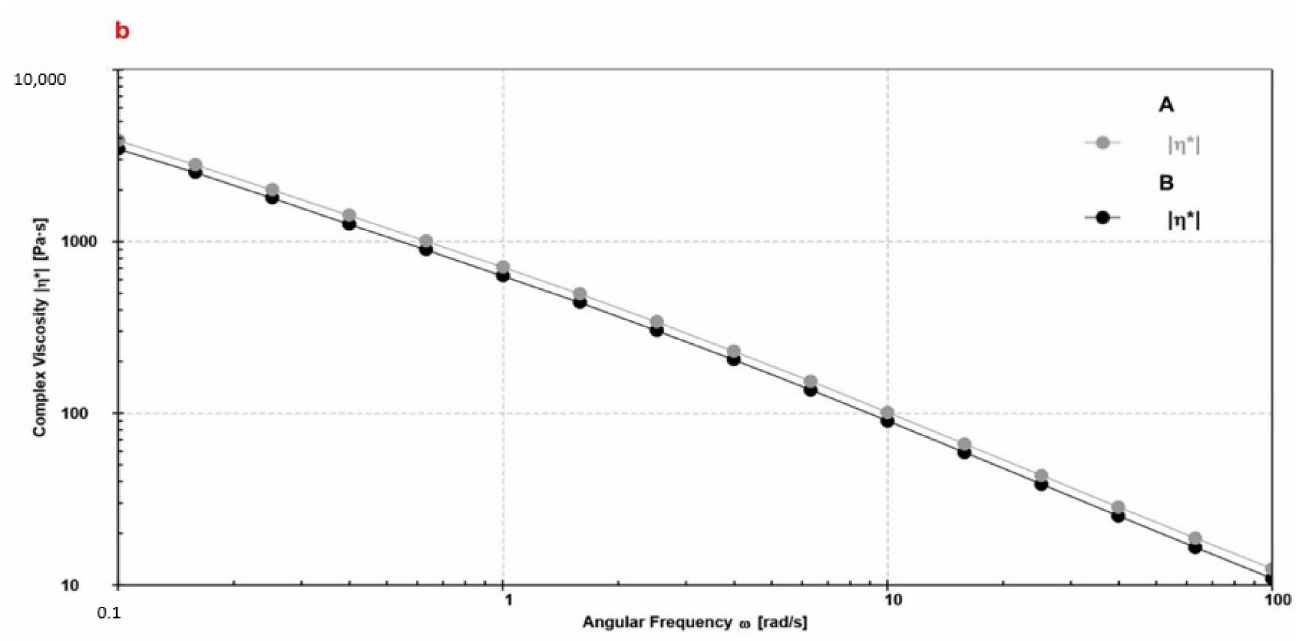
Figure 6. Mechanical spectra of the formulations A and B represented plotting the storage modulus (G (cid:48) ) and loss modulus (G (cid:48)(cid:48) ) ( a ) and complex viscosity ( η *) ( b ) as a function of angular frequency, at constant complex strain